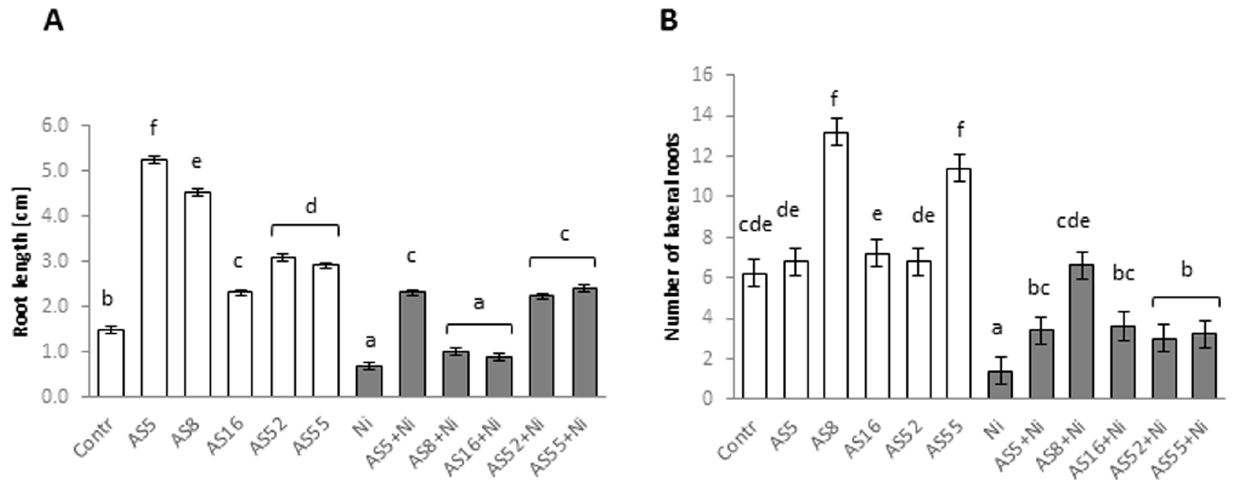
Figure 3. ( A ) Root length and ( B ) number of lateral roots of Arabidopsis plants non-exposed (bars in white) and exposed (bars in grey) to 200 µ M Ni for 4 weeks in the absence or presence of rhizobia. Error bars represent ± SD. The same letters indicate the homogenous groups according to the Tukey HSD test at the level p = 0.05.